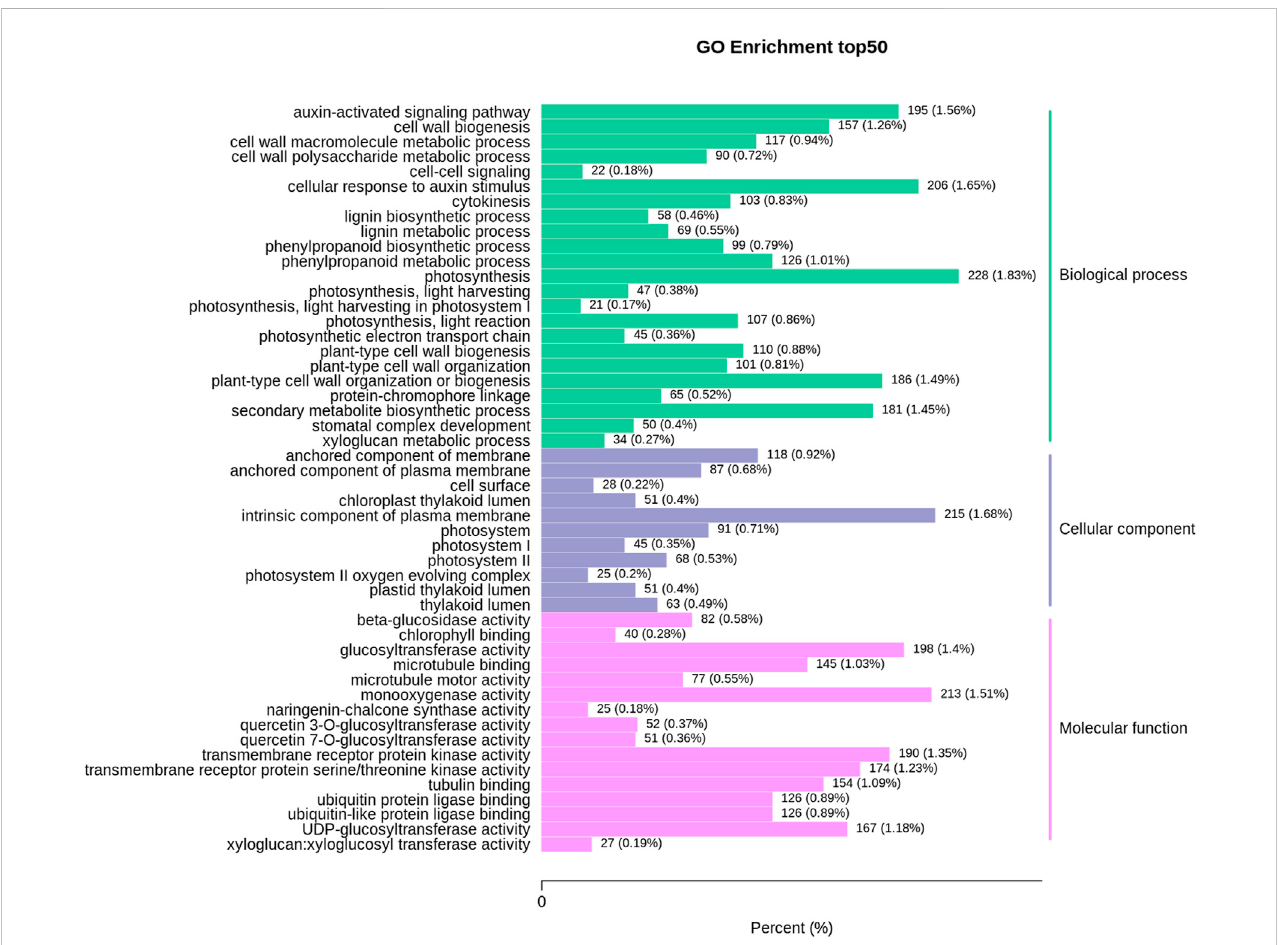
FIGURE 3 The column chart of differentially expressed genes in the leaf and root samples of V. mengtzeanum for topGO enrichment classi fi cation. The X -axis indicates the ratio of genes annotated to the total number of genes annotated to the pathway, and the Y -axis indicates the name of the KEGG pathway. The labels on the right side of the graph represent the classi fi cation to which the GO terms